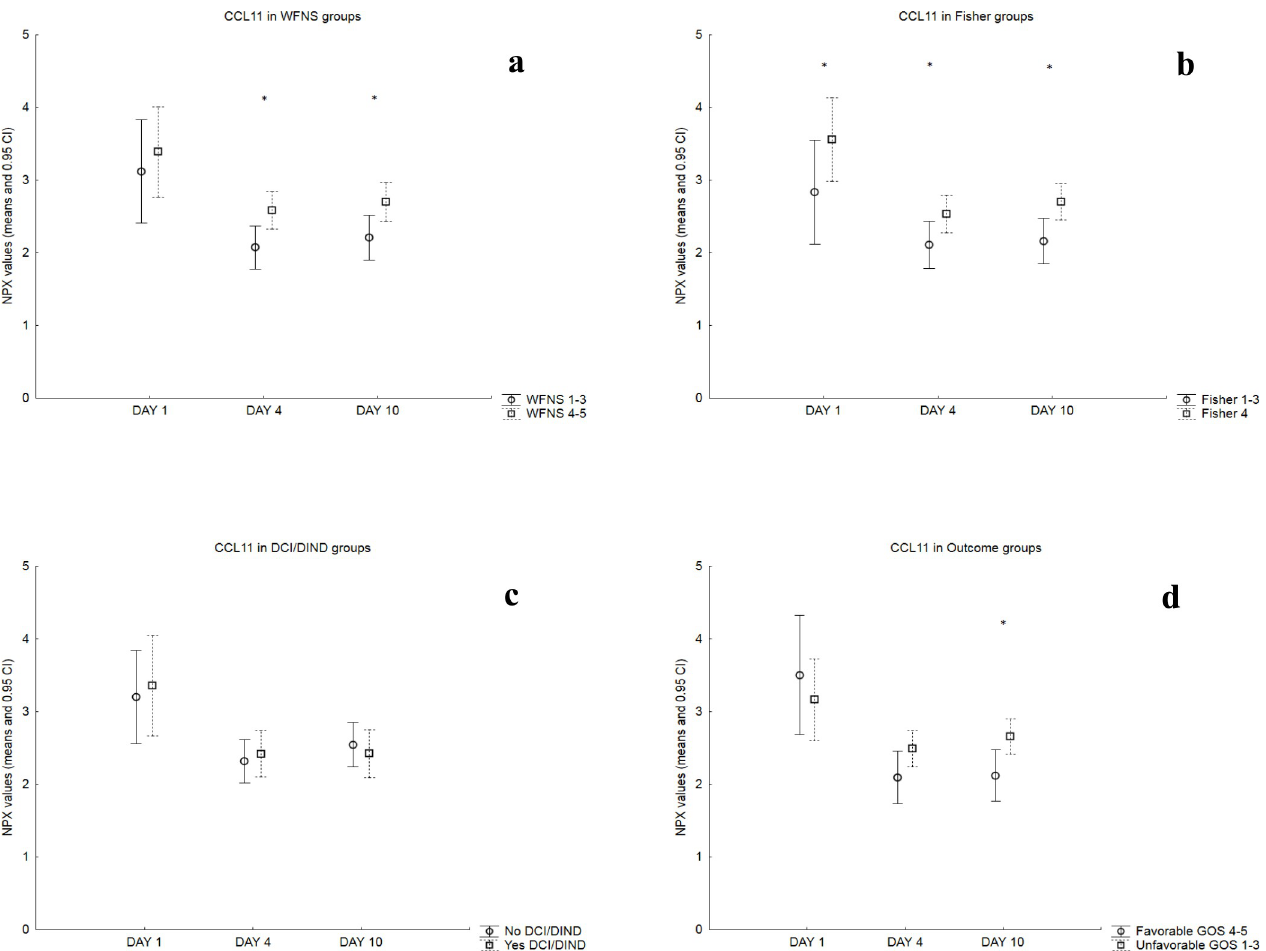
Fig 4. Comparisons of CCL11 NPX values in patient groups: Mean NPX values and 0.95 CI for each day in dichotomized patient groups based on a) WFNS score on admission ( top left ), b) Fisher scale of admission CT ( top right ), c) occurrence of DCI/DIND ( bottom left ) and d) clinical outcome ( bottom right ). Asterisks on the top left and right images as well as the bottom right image mark statistically significant differences in mean NPX values for the respective day in each group.